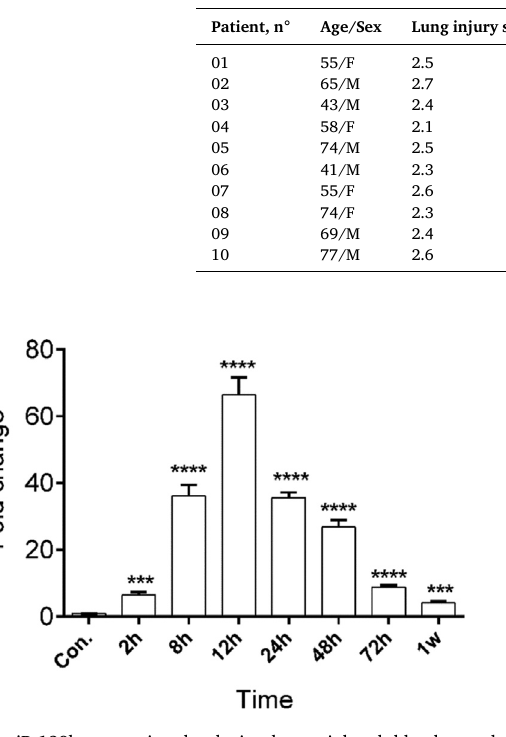
Figure 7. miR-128b expression levels in the peripheral blood samples of patients with Acute Respiratory Distress Syndrome (ARDS) ( n = 10) and healthy controls ( n = 10) at different hours after the onset of ARDS. **** p <